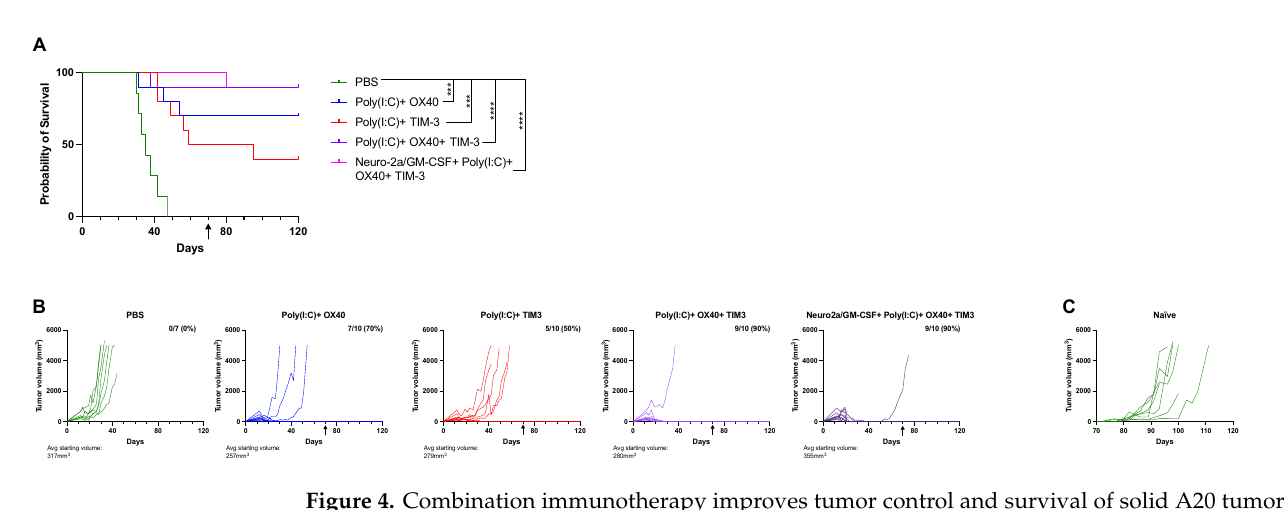
tumor and splenic immune cell subsets 24 h after the second intratumoral dose. This timepoint was selected to allow for evaluation of tumor and spleen in all groups, as many treatment groups had undetectable tumors 24 h after the third intratumoral immunother- apy dose. Only modest alterations were seen at this timepoint. In spleens, there was a slight increase in B cells and decrease in CD4 T cells, in particular naïve CD4 T cells, in the Poly(I:C)+ OX40 +TIM-3 when compared to mice receiving PBS injections (Figure 5A,C,G, p < 0.05). Tumor lymphoid subsets were highly variable across treatment groups at this timepoint and did not reach statistical significance (Figure 6). T-cell polarization subsets of helper/cytotoxic type-1, helper/cytotoxic type-2 and helper/cytotoxic type-17 inflam- matory T cells were also evaluated in spleens (Supplementary Figure S2) and tumors (Supplementary Figure S3) and were not different across groups. T-cell functionality markers are minimally different in lymphoid tissues and tumors at 24 h post immunotherapy. This work aimed to identify T-cell-mediated mechanistic differences induced by each immunotherapy regimen by evaluating markers of T-cell functionality or cytotoxicity. Interferon- γ (IFN- γ ) is a pro-inflammatory cytokine that is upregulated during an immune response and is produced by activated T cells [31]. Thus, we evaluated the level of intracellular IFN- γ in both CD4 and CD8 T cells in spleen, lymph nodes (LN), tumor-draining lymph nodes (TDLN) and tumors from mice in each treatment regimen. Unexpectedly, there was increased IFN- γ + splenic CD4 T cells in the PBS-injected group as well as the Poly(I:C)+ TIM-3 (Figure 7A, p < 0.05). There was also a slight increase of IFN- γ + CD4 in PBS-injected TDLN when compared to Poly(I:C)+ TIM-3 mice (Figure 7G, p < 0.05). IFN- γ + CD8 T cells were significantly lower in Neuro2a/GM-CSF combination therapy-injected LN compared to all groups except Poly(I:C)+ TIM-3 (Figure 7E, p < 0.05) and in TDLN when compared to PBS-injected mice (Figure 7H, p < 0.05). Spleen and tumor levels of IFN- γ + CD8 T cells were not different across groups (Figure 7B,K). We next evaluated CD8 T-cell cytotoxicity by investigating the percentage of Granzyme B+